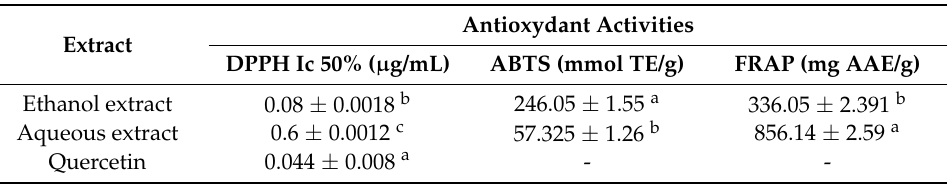
Table 1. Results of antioxidant